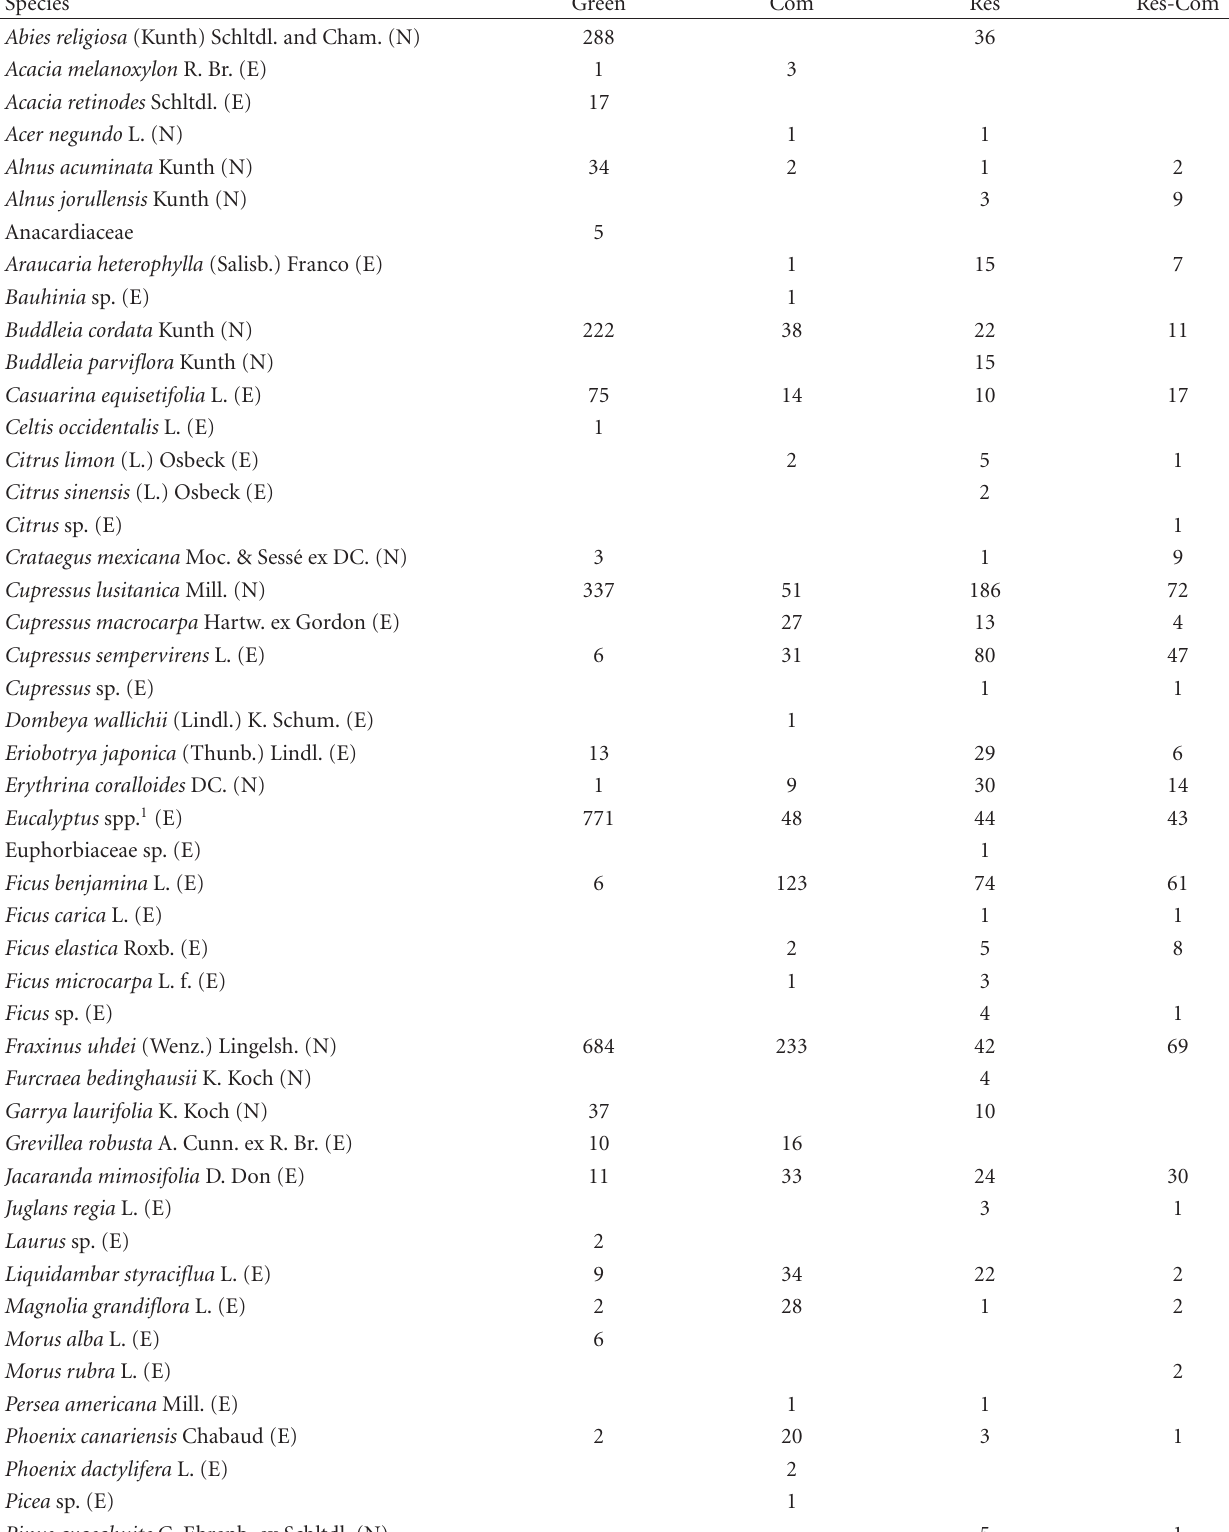
Table 1: Tree species recorded along the studied gradient of urbanization. Numbers represent the total number of individuals recorded in this study. Species are displayed alphabetically. (N): native species, (E): exotic species (see Section 3 for details). Green: green areas, Res: residential areas, Res-Com: residential-commercial areas, Com: commercial areas. Species